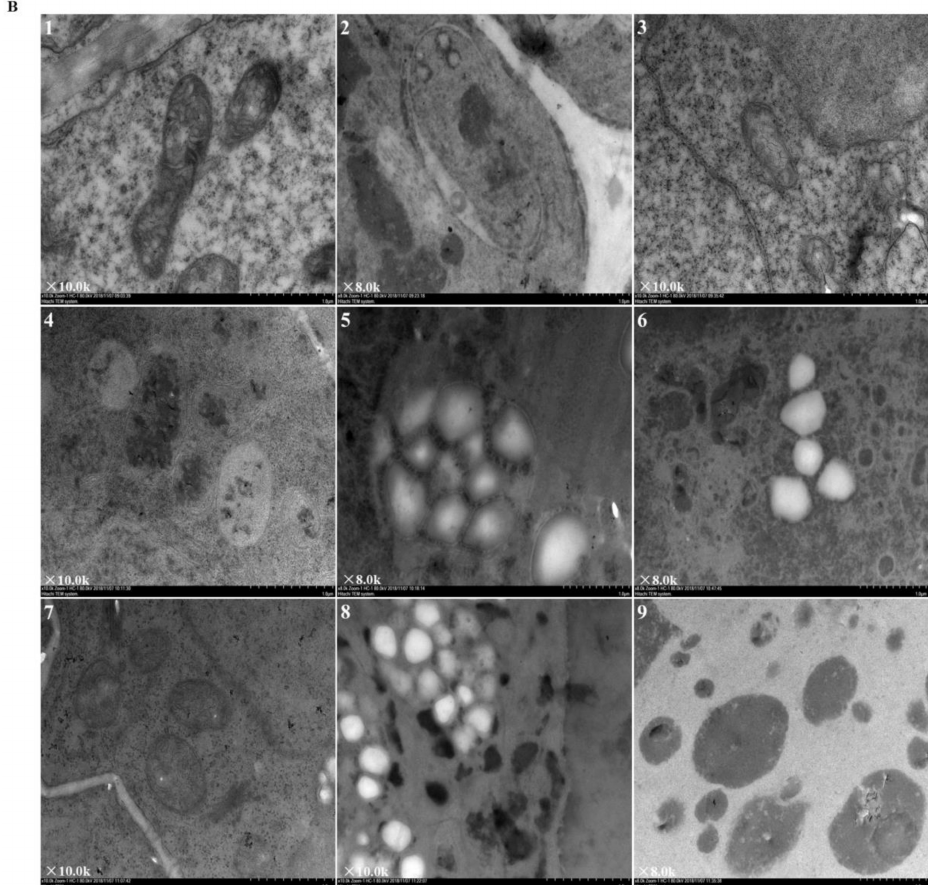
Figure 2. Ultrastructure of root tip cells of melon seedlings showing the e ff ects of root-zone CO 2 concentration. ( A ) Changes in intact root cells of oriental melon seedlings on day 0, 3, 6, 9, and 12 of high concentration rhizosphere CO 2 treatment. There is a magnification in the lower left corner of each panel. Scale bar: 5.0 µ m. The red arrow in 6 indicated that a small amount of starch grains accumulated after T2 treatment for three days; red arrows in 8, 9 indicated that at 6 day after treatment, T1 revealed fewer mitochondria and secretory vesicles emerged in plastids with very little accumulation of starch grains, T2 revealed accumulation of starch grains but a large number of organelles disappeared; red arrows in 11, 12 indicated that after 9 day of continuous treatment, T1 and T2 revealed a significant decline in the number of organelles, the accumulation of starch grains within cells increased gradually for T1, and starch grains started to be released from T2 cells; red arrows in 14, 15 indicated that after 12 day of treatment, starch grains within cells increased massively in the T1 group, together with a substantial reduction in organelles, whereas most of starch grains within T2 cells had been released, and organelles had disappeared. ( B ) Changes in organelles in root cells of oriental melon seedlings. There is a magnification in the lower left corner of each panel. Scale bar: 1.0 µ m. 1, 2, 3: Changes in mitochondria on day 6 of treatment; 4: Mitochondria on day 9 of CK (ambient CO 2 ) treatment; 5, 6: Starch granules produced by plastids on day 9 of T1 and T2; 7: Mitochondria on day 12 of CK; 8: Starch granules produced by plastids on day 12 of T1; 9: The plastid membrane remaining after starch hydrolysis in